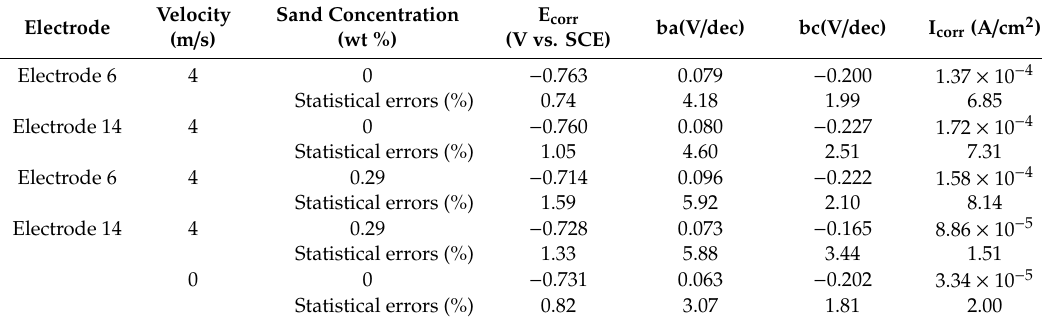
Table 3. Potentiodynamic polarization parameters of typical array electrodes 6 (outside) and 14 (inside) under flow and static